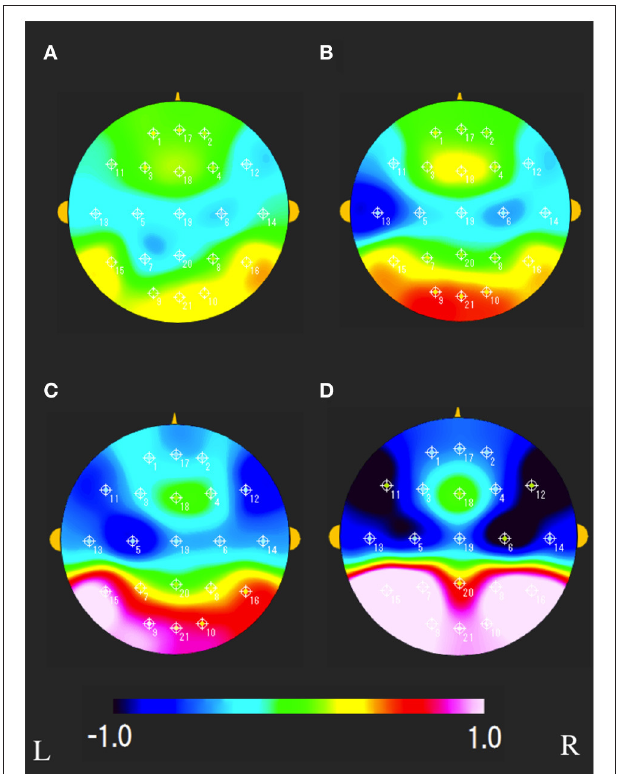
FIGURE 2 | (A) Mean sNAT plot at 7.8 Hz frequency range over occipital-temporal areas (O1, O2, T5, T6) and frontal areas (F7, F8) for group A, group B, group C, group D, VCI group, respectively. (B) Mean sNAT plot at 10.9 Hz frequency range over occipital areas (O1, O2, Oz) and fronto-temporal areas (F7, F8, T3, T4) for group A, group B, group C, group D, VCI group, respectively. * P < 0.05, ** P < 0.01 (Dunnett ’s test as control group A).